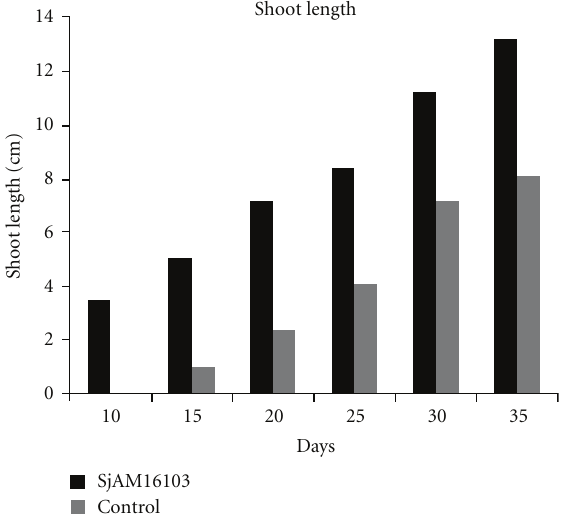
Figure 9: Inoculation of endophytic S. aquimarina SjAM16103 in A .